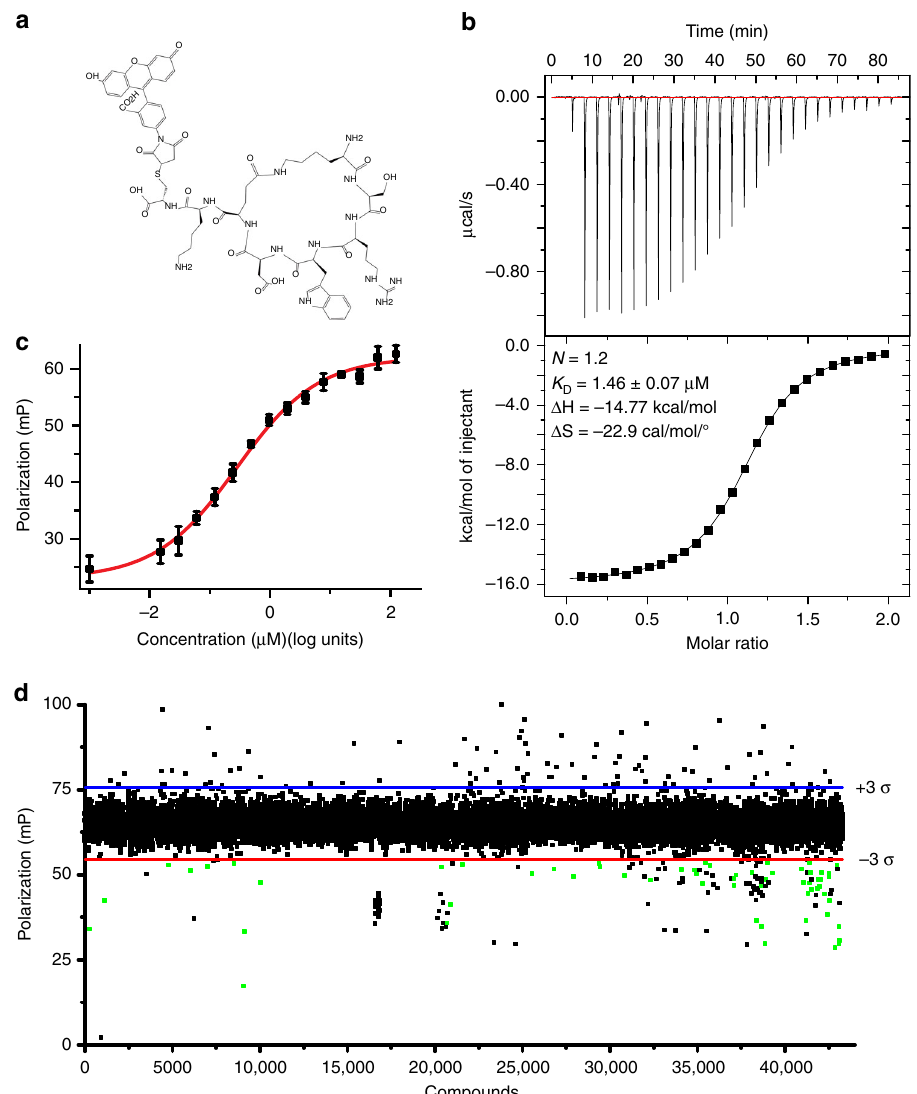
Fig. 1 HTS to identify inhibitors of UHM-ULM interaction. a Cyclic peptide tagged with fl uorescein, [sc,sc(KSRWDE)]-K-C- fl uorescein, used as tracer in HTS. b ITC shows that the binding af fi nity of the interaction between the SPF45 UHM domain and [sc,sc(KSRWDE)]-K-C- fl uorescein is 1.46 ± 0.07 μ M. Error represents fi tting error. c A fl uorescence polarization assay shows an EC 50 value for the interaction of 2.8 ± 0.4 μ M. Error bars show standard deviation of three technical triplicates and error is calculated as fi tting error ( n = 3). d Results of the 1 st HTS campaign are shown. Compounds which showed a threefold standard deviation decrease from mean value in the intensity of the polarized light and were reproducible in a duplicate assay are highlighted as green dots ( n =